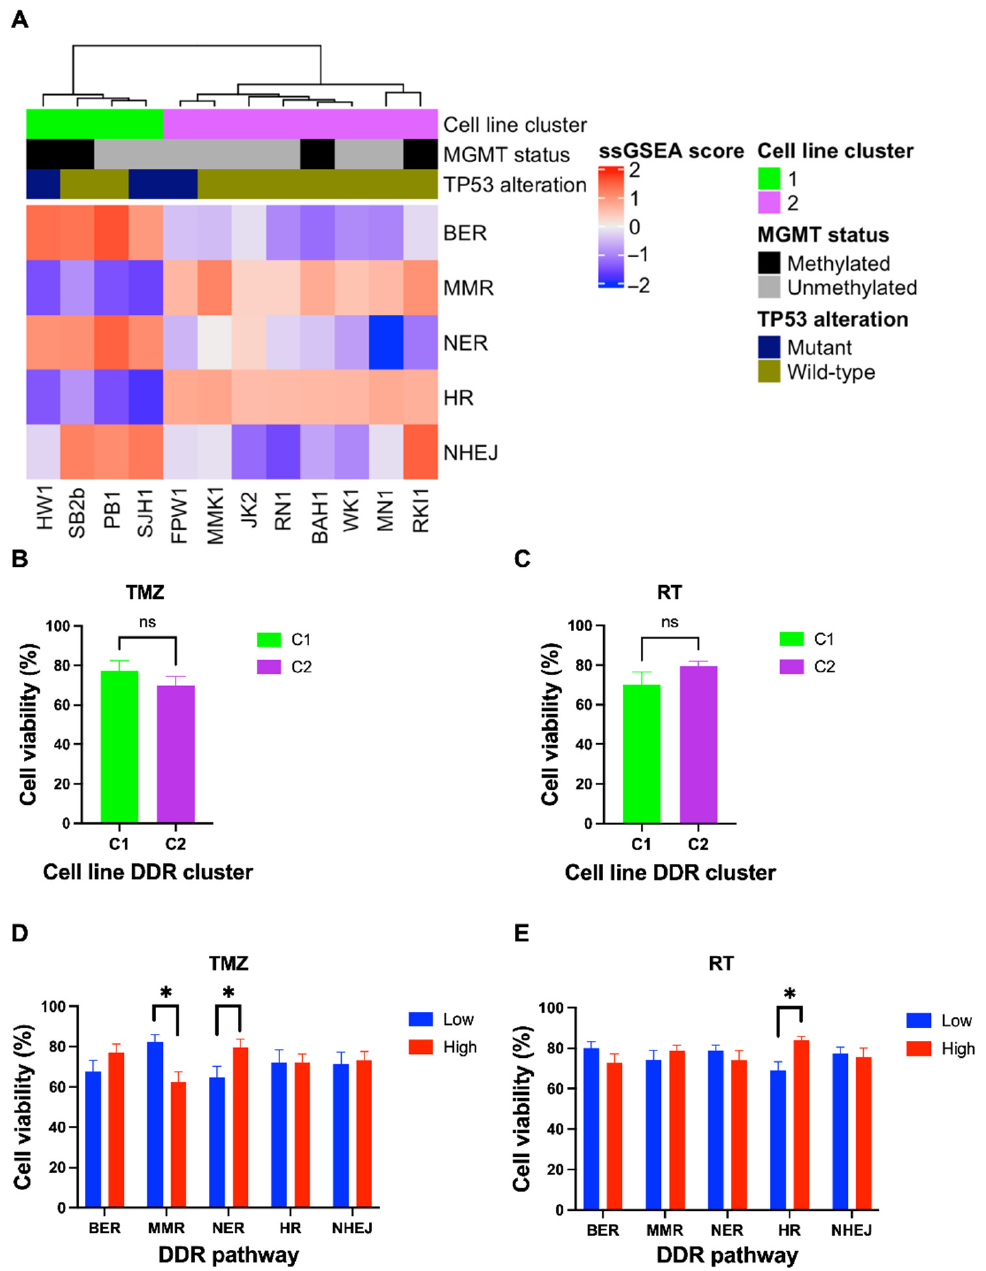
Figure 3. Transcriptomic profiling of DDR pathways in 12 patient-derived glioblastoma cell lines and response to standard treatment. ( A ) Log-transformed ssGSEA z-scores are shown corresponding to relevant DDR pathways, including MGMT methylation status and TP53 mutation of glioblastoma cell lines. Two distinct clusters were identified (C1 and C2), in which C1 had a significant upregulation of BER and NER pathways ( p = 0.004), while MMR and HR were upregulated in C2 ( p = 0.004). Cell lines were treated with a clinically relevant dose of TMZ (35 µ M) or RT (2 Gy) for 7 days, cell viability assessed using MTT assay. Cell lines were grouped and compared using a student’s t -test to assess differences in TMZ and RT response based on DDR cluster ( B , C ) as well as “high” and “low” expression of DDR pathways ( D , E ). There was no significant difference in cell viability between the C1 or C2 cell line clusters after TMZ or RT treatment ( B , C ). TMZ sensitivity was associated with high MMR gene expression, while TMZ resistance was associated with high NER gene expression ( D ). RT resistance was associated with high HR gene expression ( E ). p -values < 0.05 were considered significant (* p < 0.05) (ns =